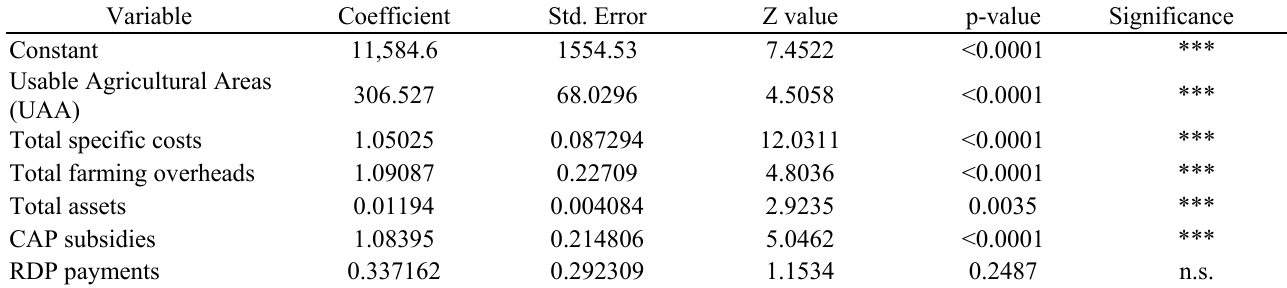
Main findings in the multiple regression model estimated by random effect panel data. Dependent variable farm net income. (Source: author’s elaboration on data http://ec.europa.eu/agriculture/rica/database/database_en.cfm)